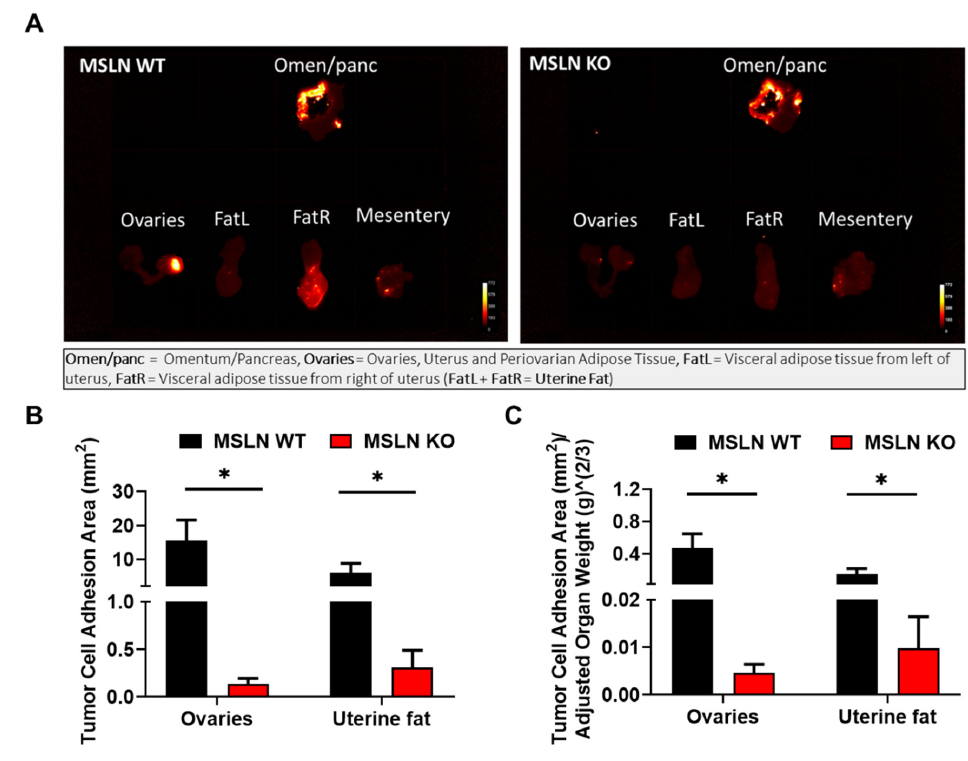
Figure 4. In vivo adhesion assay. ( A ) 3–6 month aged MSLN WT and MSLN KO mice were injected i.p. with 10 × 10 6 ID8 ovarian cancer cells tagged with RFP. Mice were sacrificed the next day and imaged to determine short-term cellular adhesion in adipocyte-rich tissues. ( B ) Cellular adhesion was quantified with ImageJ by the Tumor Cell Adhesion Area (area of the organ occupied by cell adhesion) and ( C ) Weight Adjusted Tumor Cell Adhesion Area (area of the organ occupied by cell adhesion divided by scale-adjusted weight of the organ). MSLN KO mice had significantly less cellular adhesion in the ovaries and the uterine fat (FatL + FatR). n = 5 for both MSLN WT and MSLN KO ; * p < 0.05; error bars represent standard error of mean.